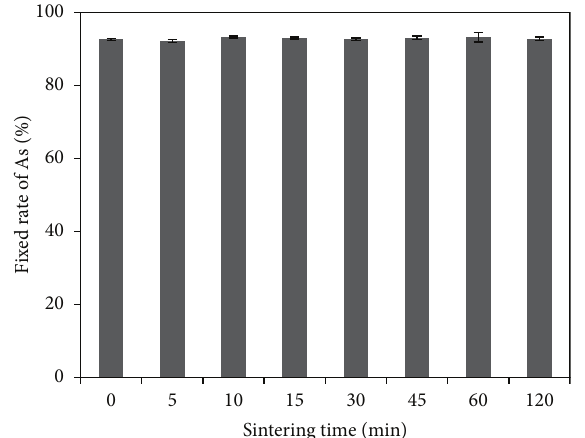
Figure 5: The fixed rates of As in sintered products at different sintering